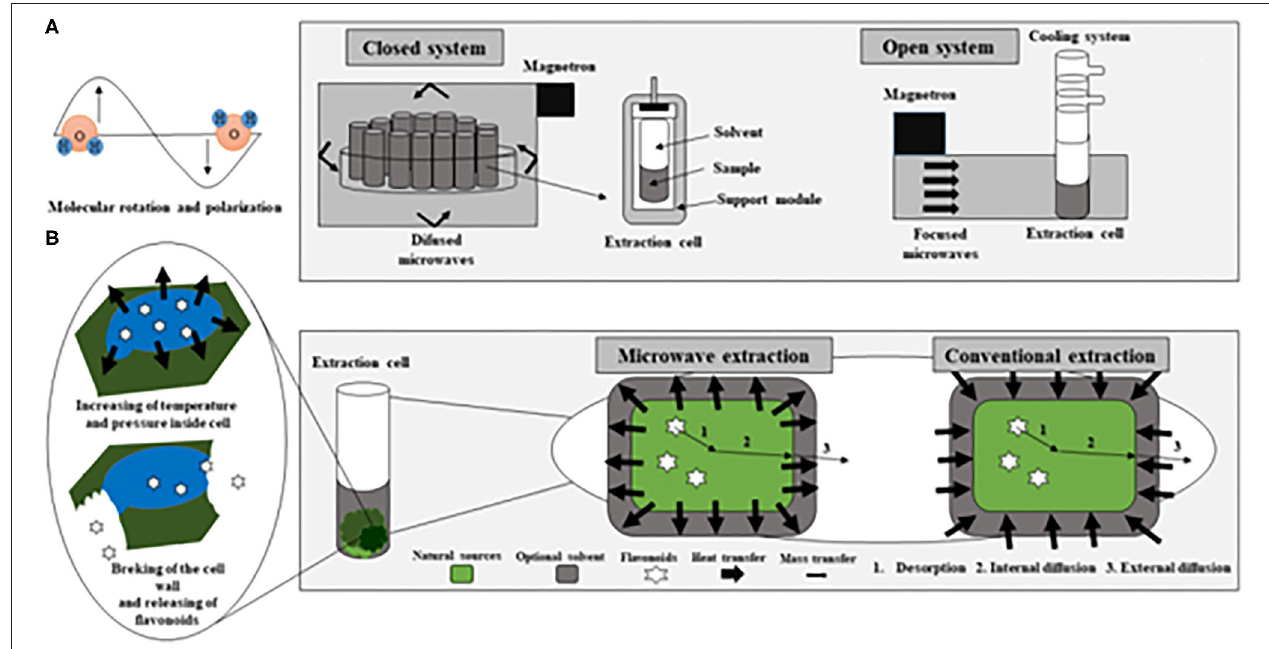
FIGURE 3 | Representative diagram of a microwave extractor in both closed and open systems (A) adapted of Camel (2001); Representative diagram of the conventional heating and microwave heating (B) adapted of Rosa et al. (2018) and Destandau et al. (2013).